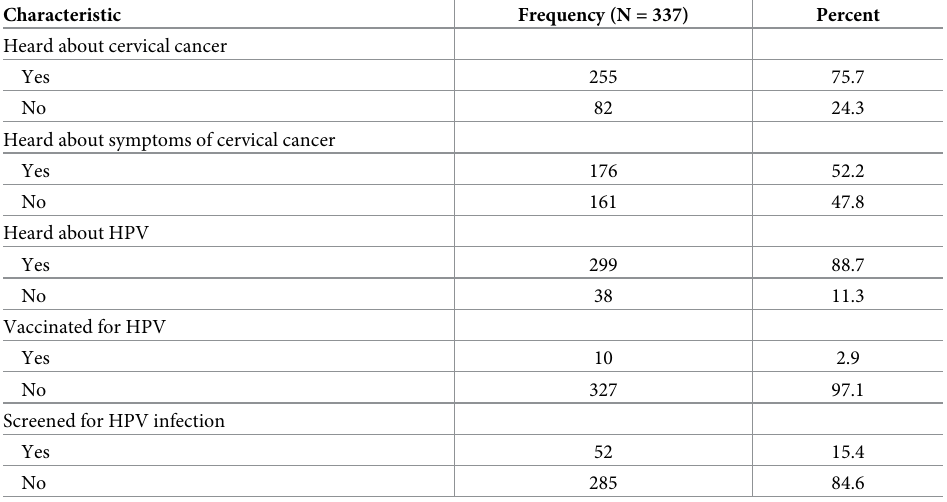
Table 2. Awareness of cervical cancer among participant women (n = 337) aged 21–49 years, Amhara region, Ethi- opia, 2019.